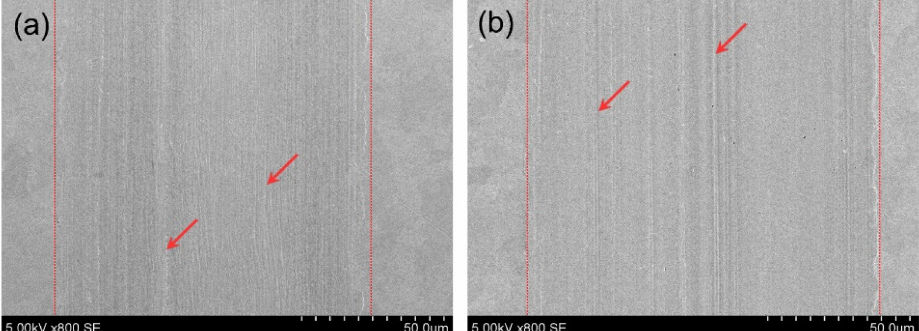
Figure 10. SEM images of segments of wear traces on the plate formed during the IL-DEE tribo-test performed at the temperatures of 30 ◦ C ( a ) and 80 ◦ C ( b ). Arrows indicate scratches, lines—boundaries of the wear